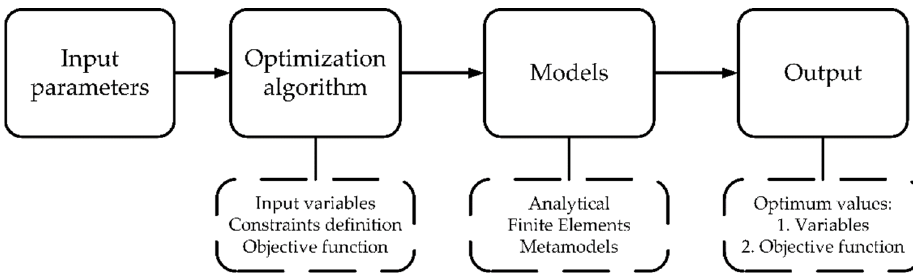
Figure 3. Scheme for solving an optimization problem.